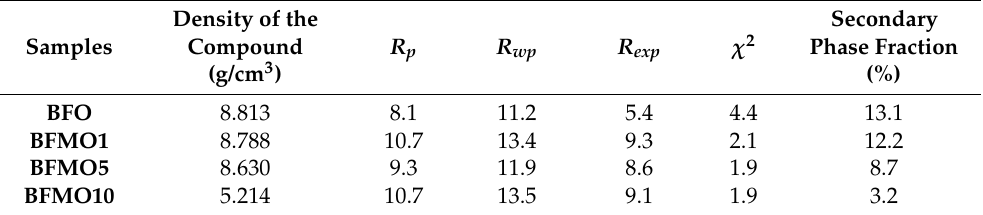
Figure 1. XRD patterns of BFO, BFMO1, BFMO5, and BFMO10 in the 2 θ range ( a ) 20–80 ◦ ; ( b ) 27–33 ◦ . Table 1. Structural parameters and secondary phase fraction obtained from Rietveld refinement of XRD